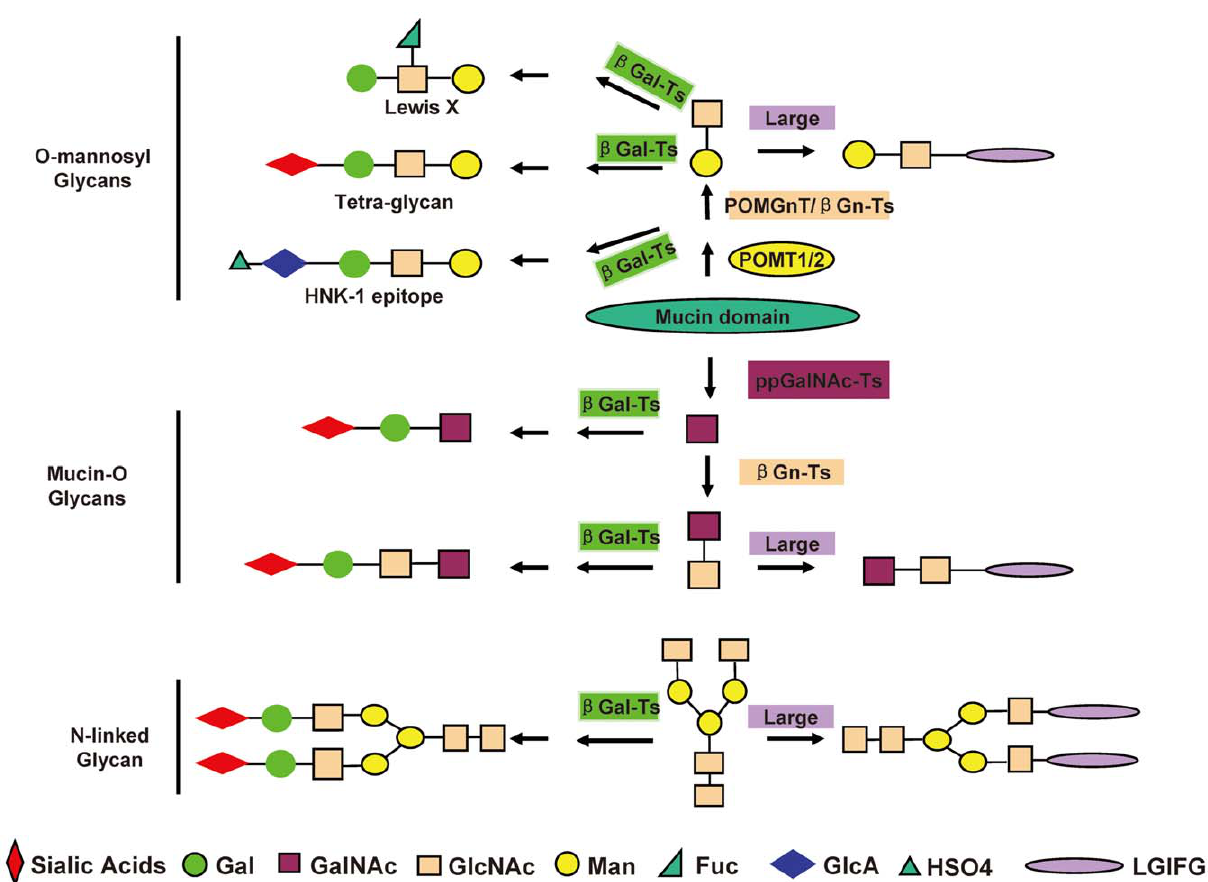
Figure 6. Illustration of the role of Large in the glycosylation of a -DG. LGIFG: Large-induced functional glycans.